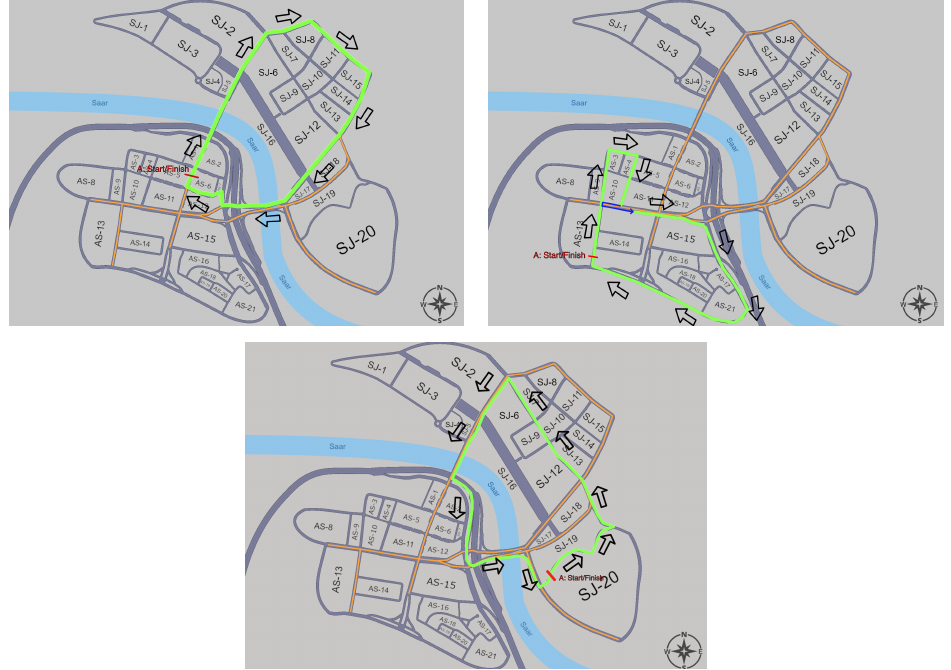
Figure 2. Three printed maps corresponding to the driving routes employed. To compensate for the relative shortness of the second map ( top right ), the change of the driving direction ( blue highlight ) was integrated into the driving